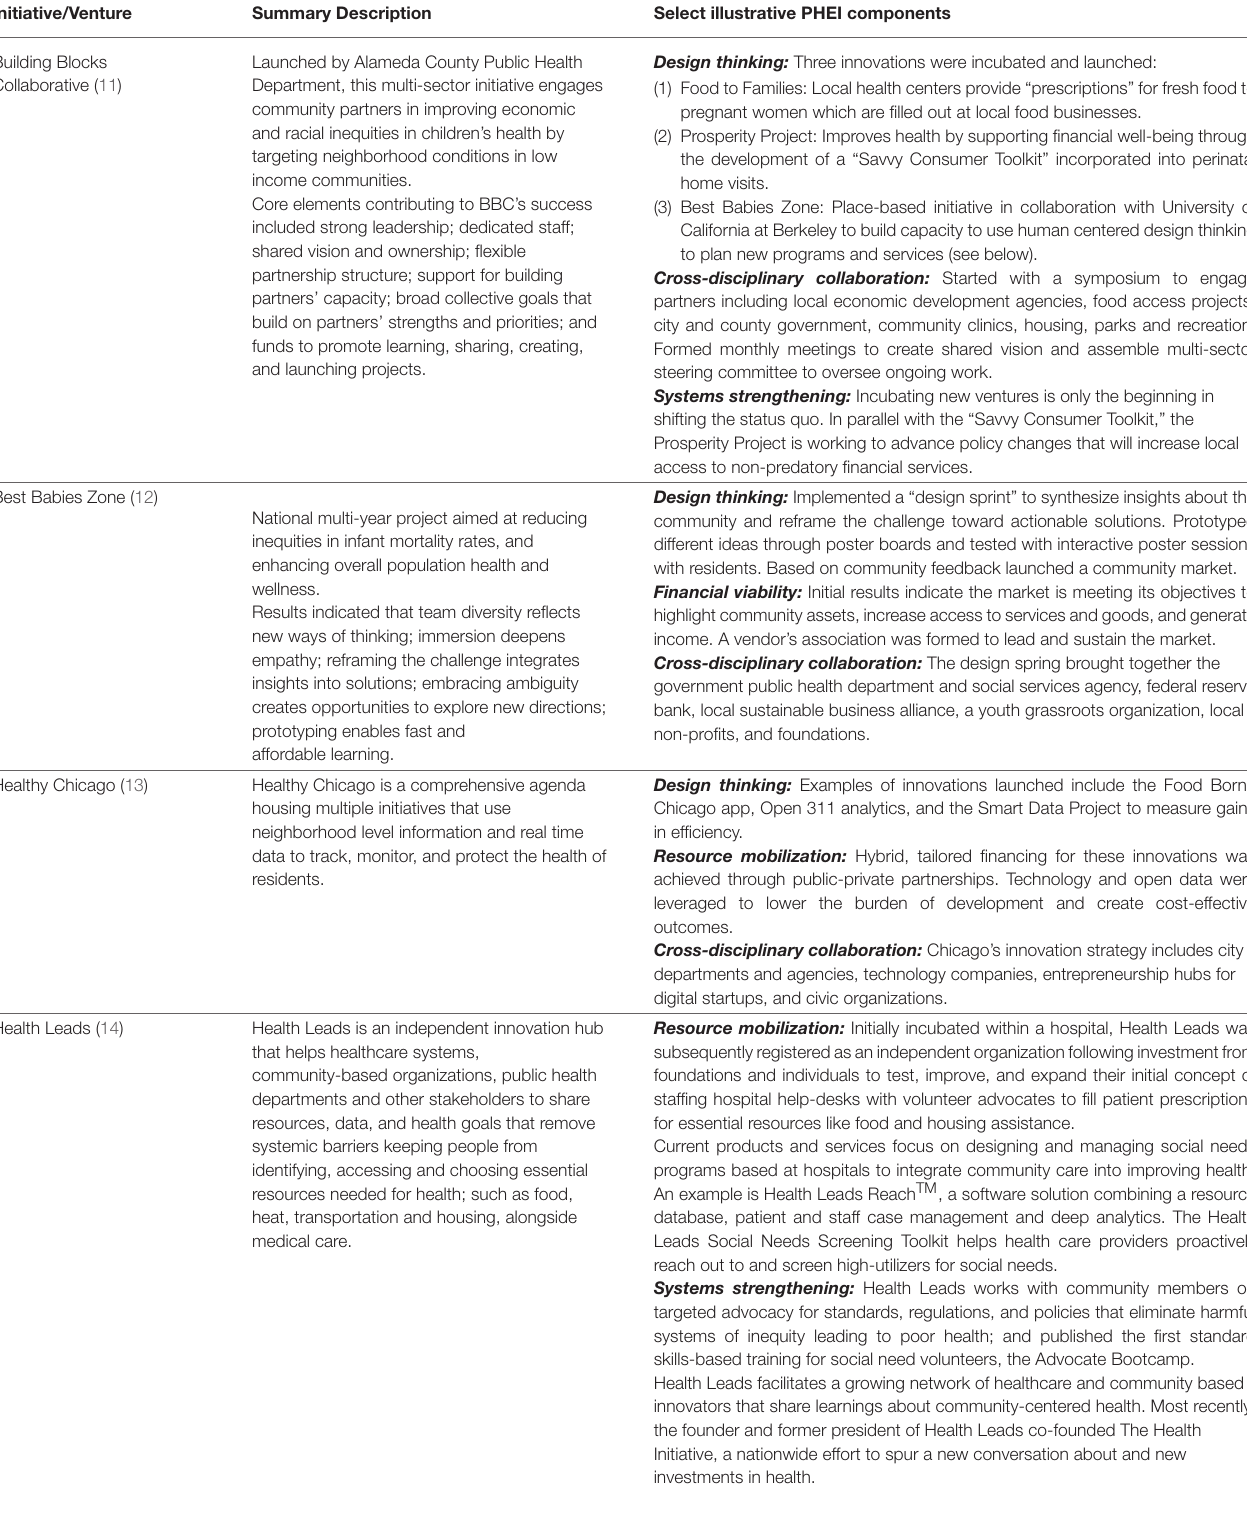
TABLE 1 | Case examples from literature review illustrating key components of public health entrepreneurship and intrapreneurship.